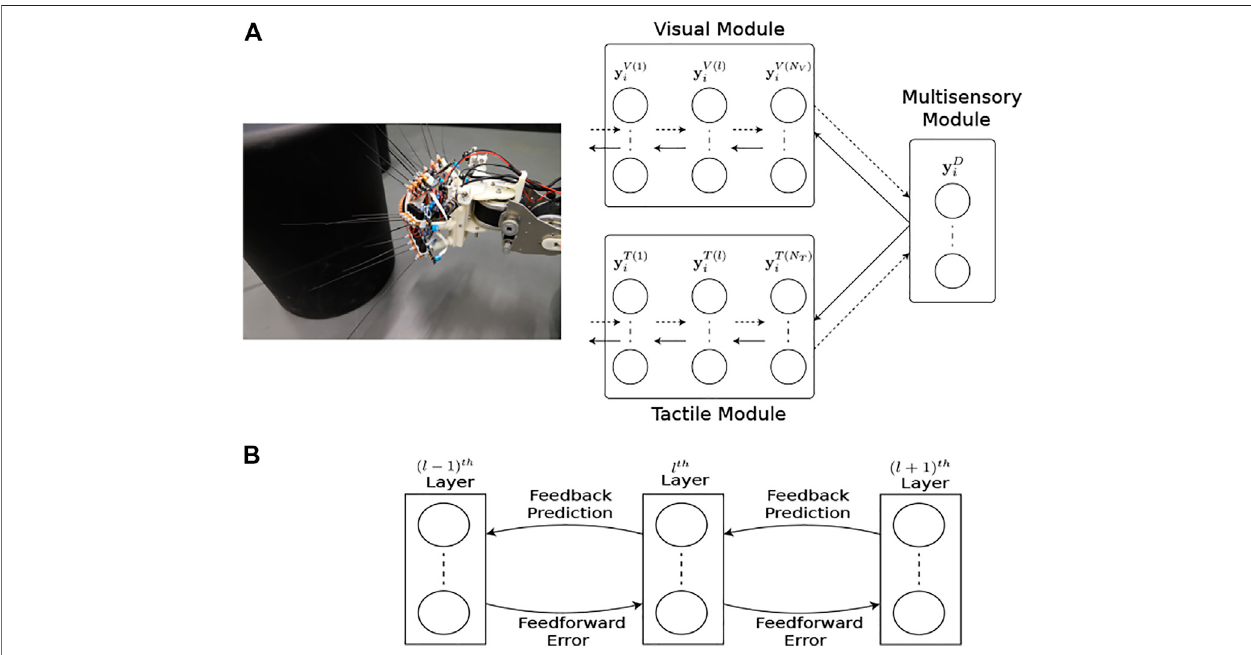
FIGURE4| Multimodal predictive coding networkarchitecture. (A) Thenetworkconsistsof3neuralnetworkmodules; theVisualand Tactilemodulestaking visual and tactile input from the WhiskEye robot with N V and N T layers respectively; and the Multisensory module consisting of a single layer that predicts the activities of the neurons in the last layers of both the visual and tactile modules. Note that each layer in the Visual and Tactile modules are also predicting the activities of neurons in their preceding layers as shown in panel (B) , passing prediction errors forward through the network.